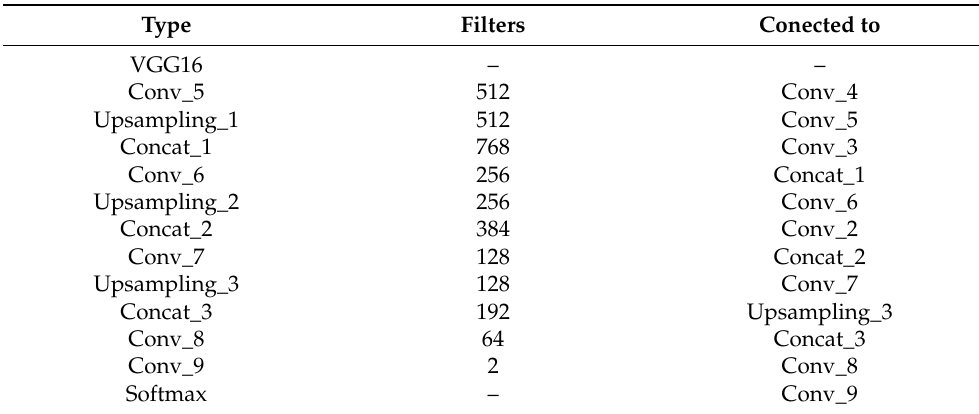
Figure 10. Architecture of the VGG16+U-Net. Table 4. Layer description of the